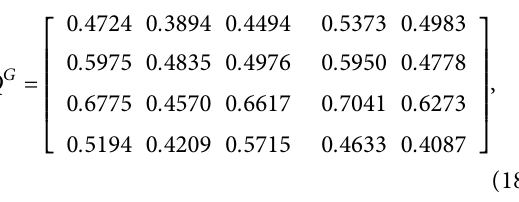
Algorithm 3 are missing. .e analyses process is performed